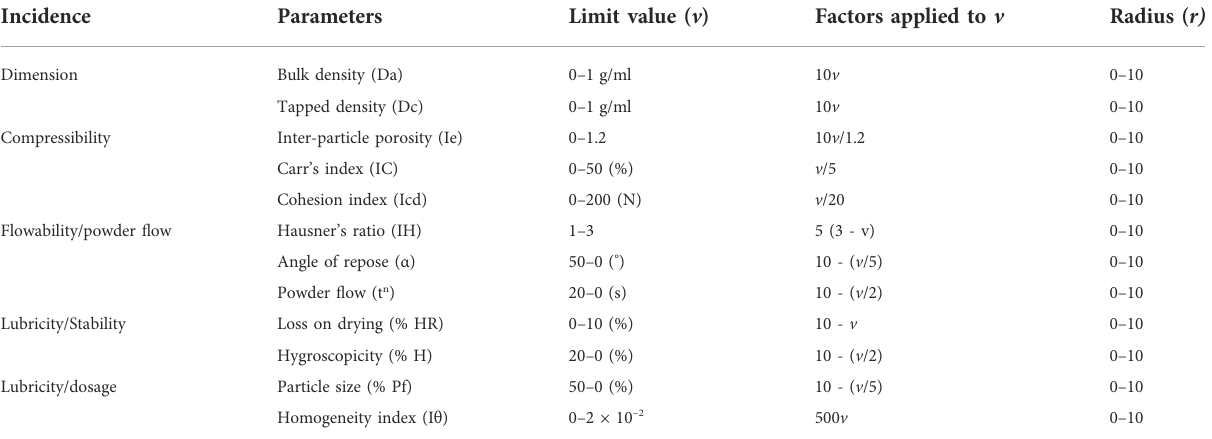
TABLE 2 SeDeM Parameters, indices, limit values and calculating factors.